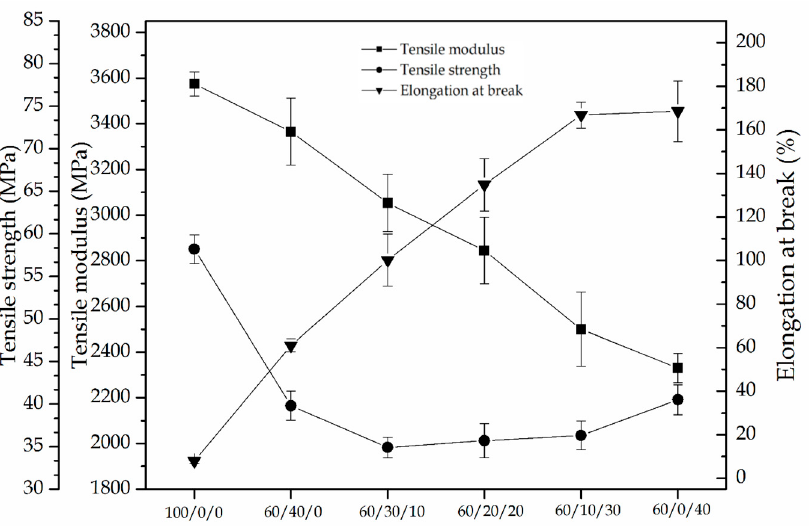
Figure 1. Plot evolution of mechanical tensile properties of PLA/PHB/PCL ternary blends as a function of their composition (wt % PLA/wt % PHB/wt % PCL).